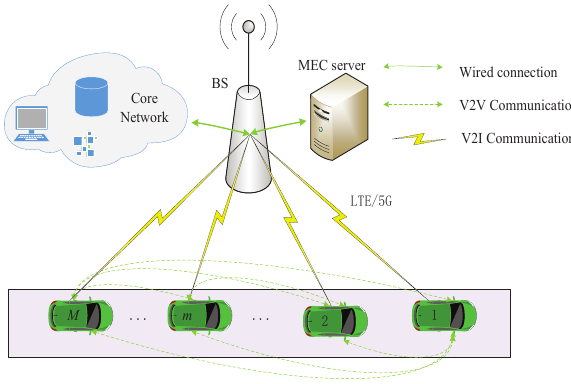
Figure 1. Task offloading scenario.